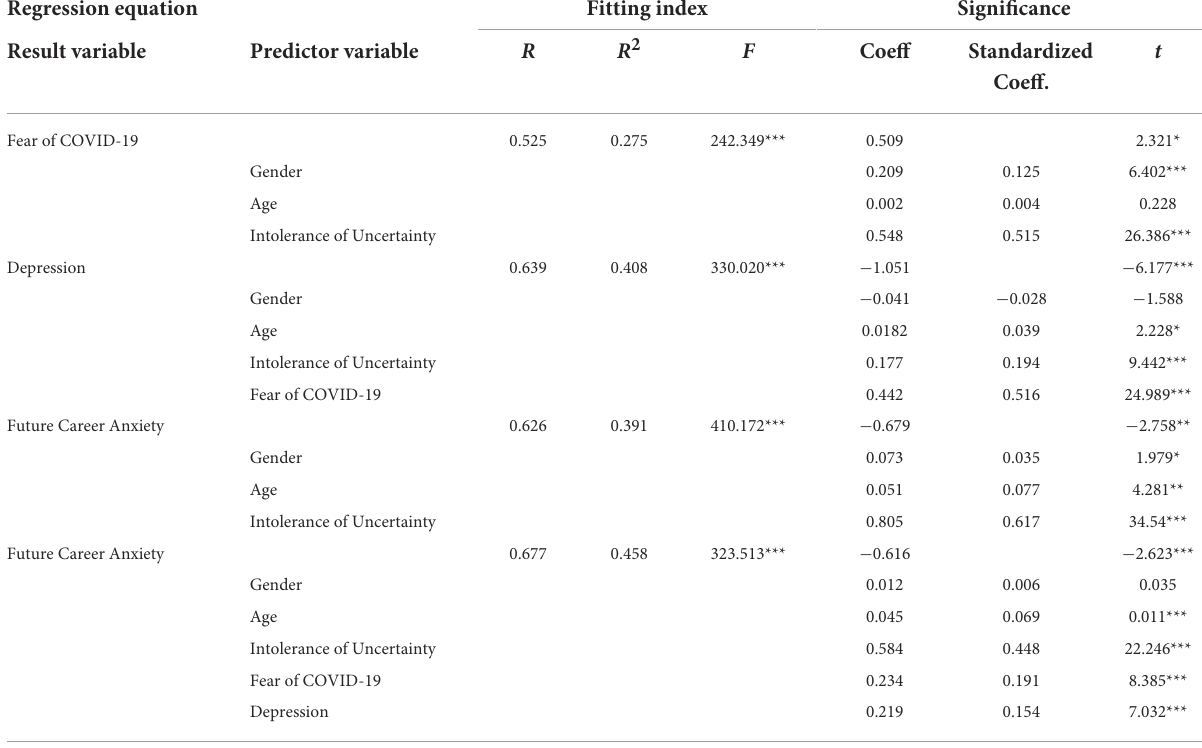
TABLE 2 Regression analysis of relationship between Fear of COVID-19 and Depression with mediation analyses ( N = 1,919). Regression equation